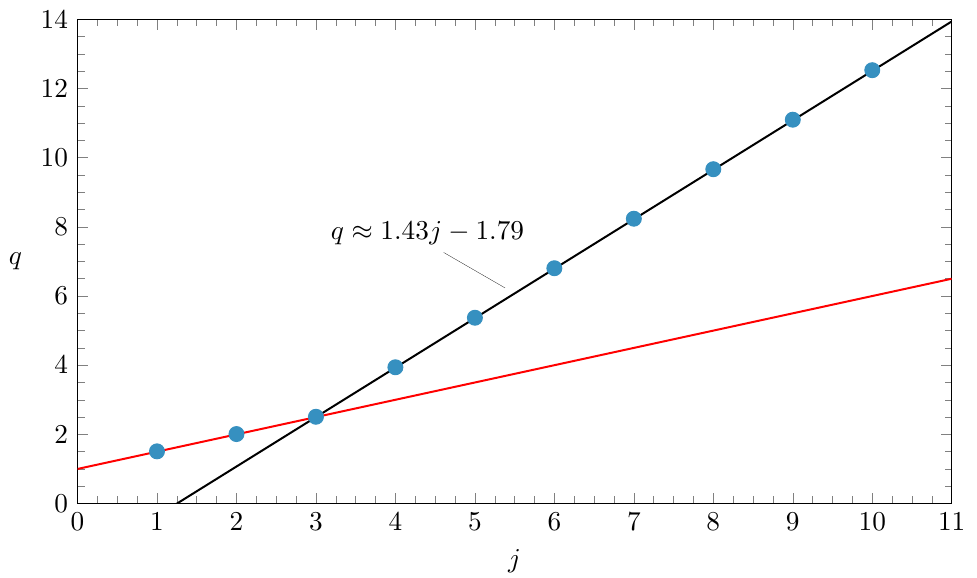
Figure 3 . Lower bounds on the conformal dimension as a result of the ANEC for [ L; A 2 ] multiplets. Each point is the result of a bisection algorithm done with sdpb [23] (see section 5.4). The red line is the unitarity bound q = 1 j + 1. The operators for j 6 3 that lie on the red line satisfy [ A 1 ; A 2 ]. 2 (cid:12)gure 1. The operators at the unitarity bound, which satisfy the [ A 1 ; A 2 ] shortening, are not allowed for j > 3 (see below). Therefore, for j > 3 the ANEC provides a constraint strictly stronger than